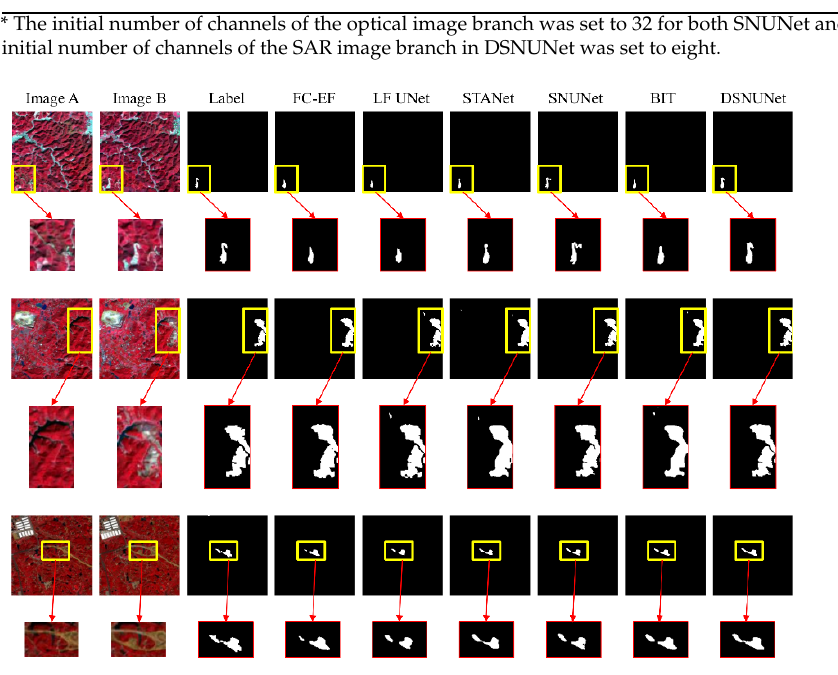
Figure 7. Prediction results of DSNUNet and other models based on optical images.